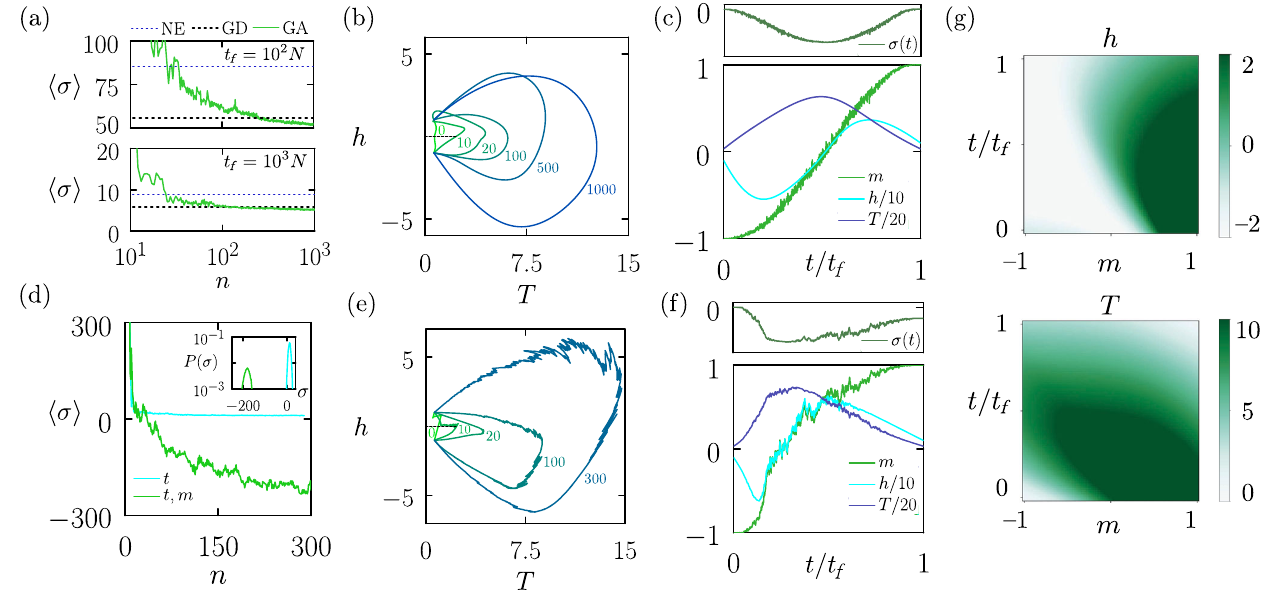
FIG. 3. Magnetization reversal in the Ising model. (a) Mean entropy production h σ i under protocols learned by a demon given time as input, as a function of GA generation n (green line). Trajectory lengths are 10 2 (top) or 10 3 (bottom) Monte Carlo sweeps. Also shown are values due to entropy-minimizing protocols found by near-equilibrium approximation [17] (NE) and gradient descent [22] (GD). (b) Parametric protocols [ T ð t Þ ; h ð t Þ ] learned after n generations. The black dashed line is the Ising model first-order phase-transition line, which ends at the critical point [35]. (c) Single trajectory under the protocol learned after 10 3 generations. (d) – (f) Similar to panels (a) – (c), but now the demon receives time and global magnetization m as inputs. The top sections of panels (c) and (f) show time-resolved entropy production along each trajectory (the vertical axis is 10 3 units long): This information is not available during training nor used by the demon. In panel (d), we also show the case in which the input is time only (cyan line), and in the inset of that panel, we show entropy production distributions over 10 4 trajectories for protocols learned using time (cyan line) and time and magnetization (green line) as inputs. (g) Visualization of the demon feedback-control protocol learned after 300